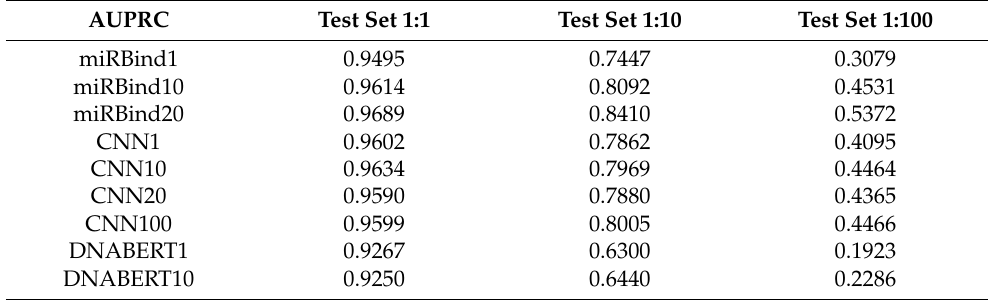
Table 1. The area under the precision-recall curve (AUPRC) for the miRBind, CNN, and DNABERT models, tested against 1:1, 1:10, and 1:100 left-out test sets. The number used in the naming of each model indicates the positive:negative ratio on which the model was trained. We selected the best-performing miRBind and CNN models (miRBind20 and CNN10, henceforth called miRBind and CNN, respectively), as the proposed methods of our work.